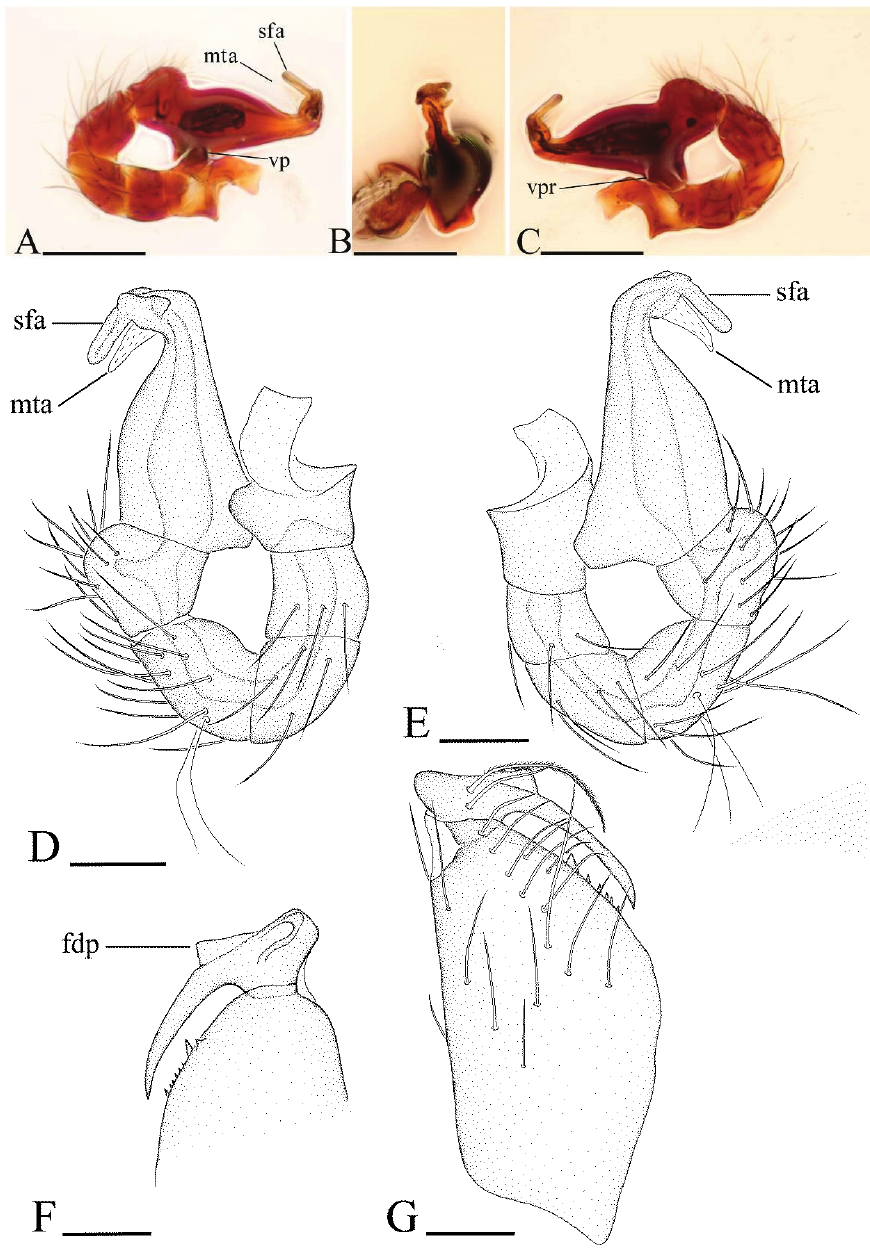
Figure 9. Ischnothyreus dactylinus sp. n., male. A, D left palp, prolateral view B distal part of palpal bulb, apical view C, E left palp, retrolateral view F , G left chelicera, posterior and anterior views. Abbrevia- tions: fdp = flake-like dorsal process; mta = membranous, triangle-shaped apophysis; sfa = sclerotized, finger-like apophysis; vp = ventral projection; vpr = ventral protuberance. Scale bars: A–C = 0.1 mm; D–G = 0.05